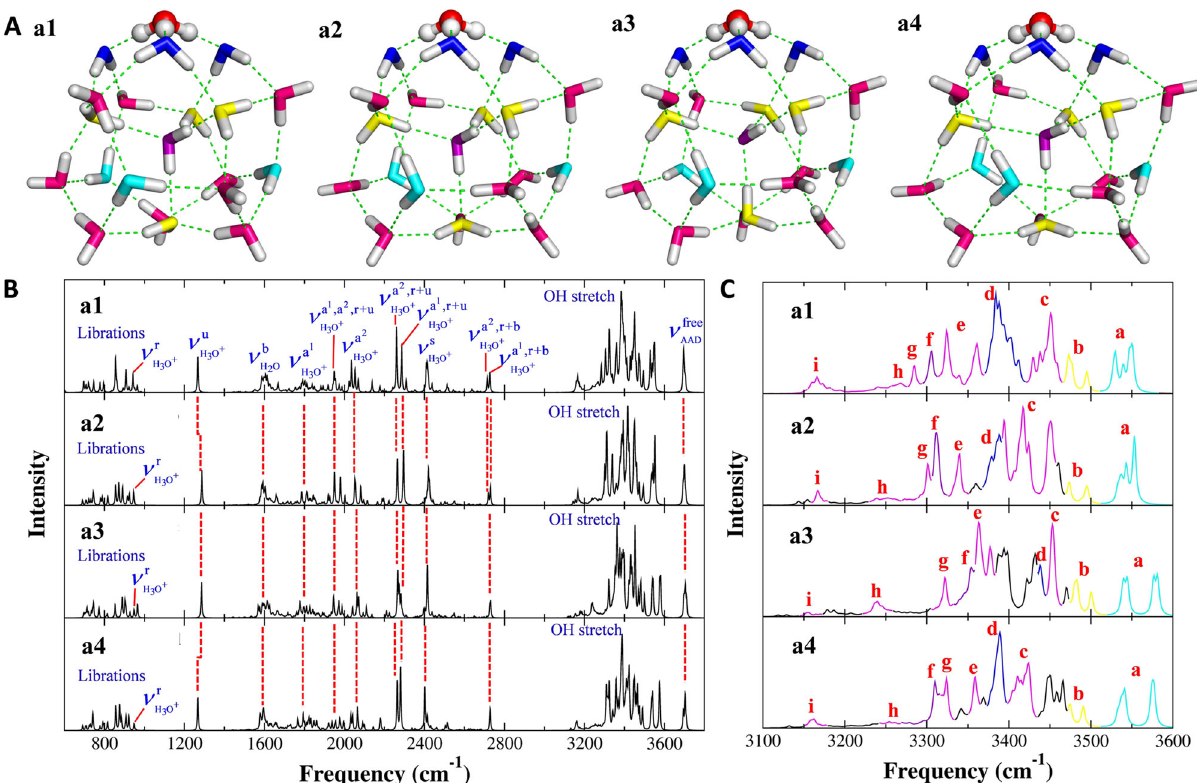
Fig. 5 Different minimum energy structures and corresponding IR spectra. A Overview of the four minimum energy structures of H + (H 2 O) 21 reported in Hodges and Wales ’ s study 33 , and ( B ), ( C ) the corresponding VQDPT2 IR spectra computed at the fragment-based CCD/aug-cc-pVDZ level. The enlarged view of the O-H stretching region of the spectra in ( C ) is color-coded according to the type of the corresponding water